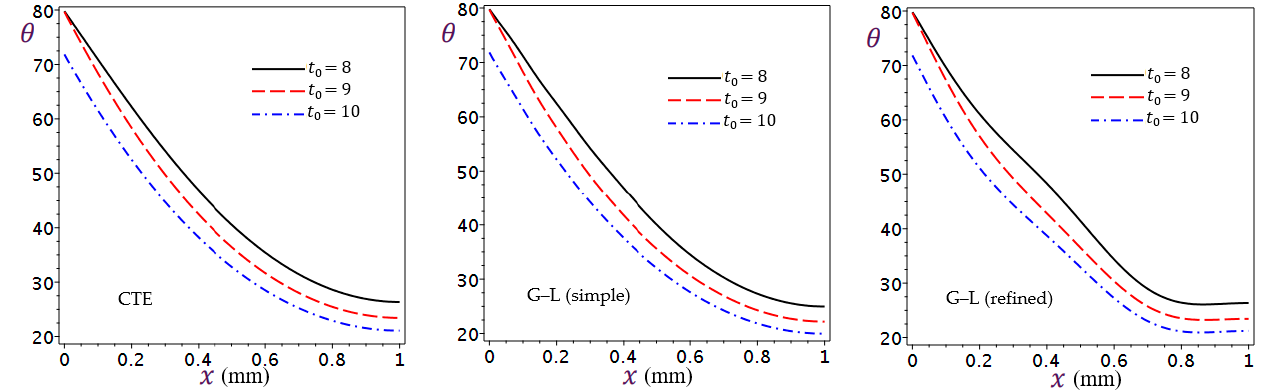
Figure 6. Effect of ramp-type heating parameter t 0 on temperature θ